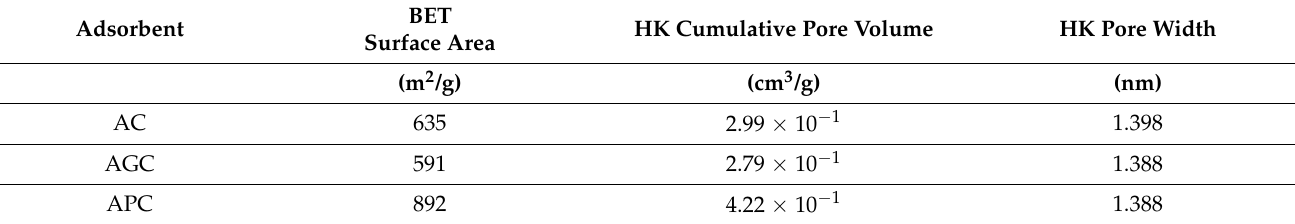
Table 1. Surface area properties of